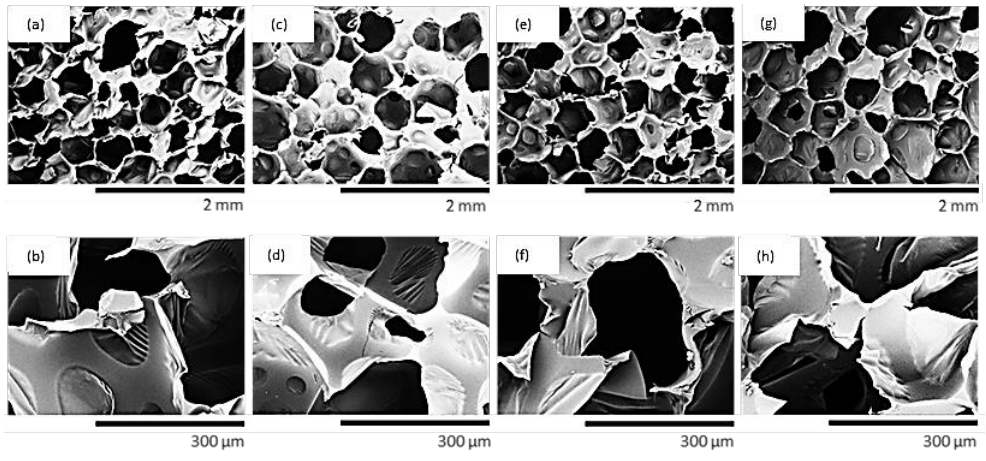
Figure 5. Cellular structure of ( a , b ) PUR_0, ( c , d ) PUR_WS_NT, ( e , f ) PUR_WS_A and ( g , h ) PUR_WS_S.